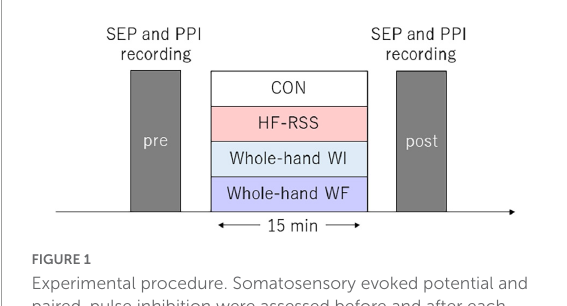
FIGURE1 Experimental procedure. Somatosensory evoked potential and paired-pulse inhibition were assessed before and after each intervention for 15 min. Each intervention was conducted in random order for each